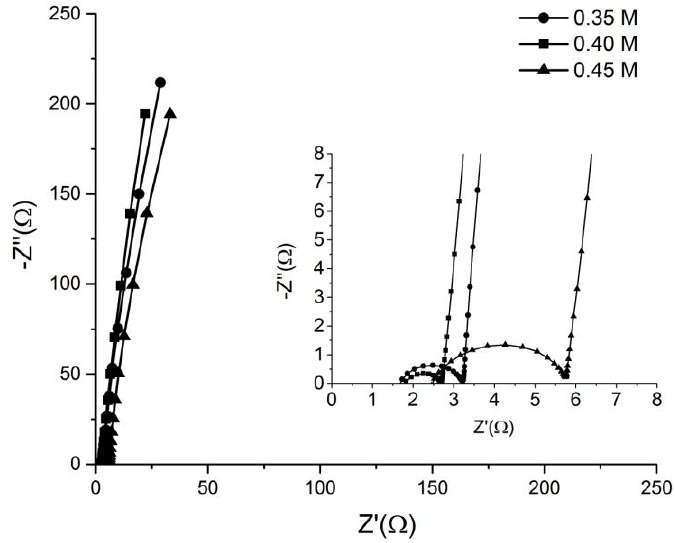
Figure 1: Nyquist plots within the frequency range of 400 KHz to 0.01 Hz for the PANI / GPE /PANI redox capacitors fabricated using electrodes with different aniline